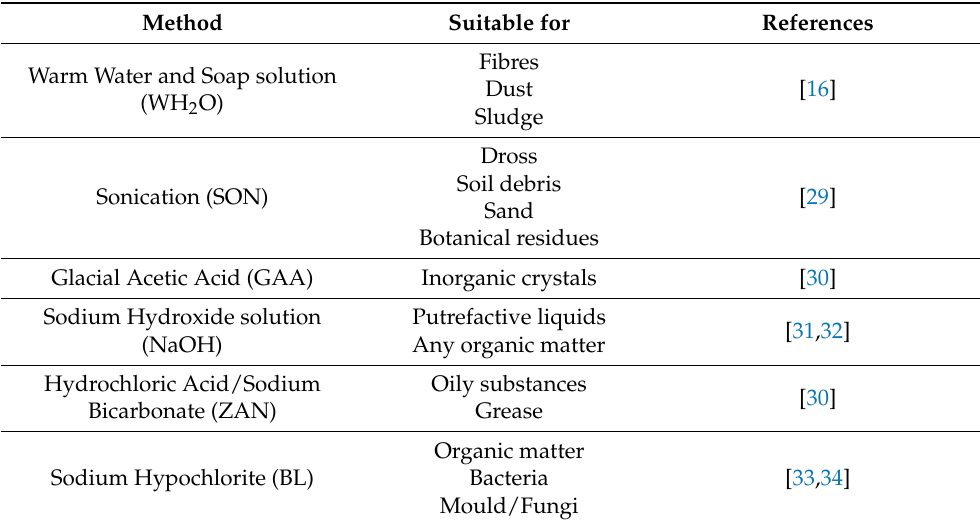
Table 1. Cleaning methods tested with reference and target substances.